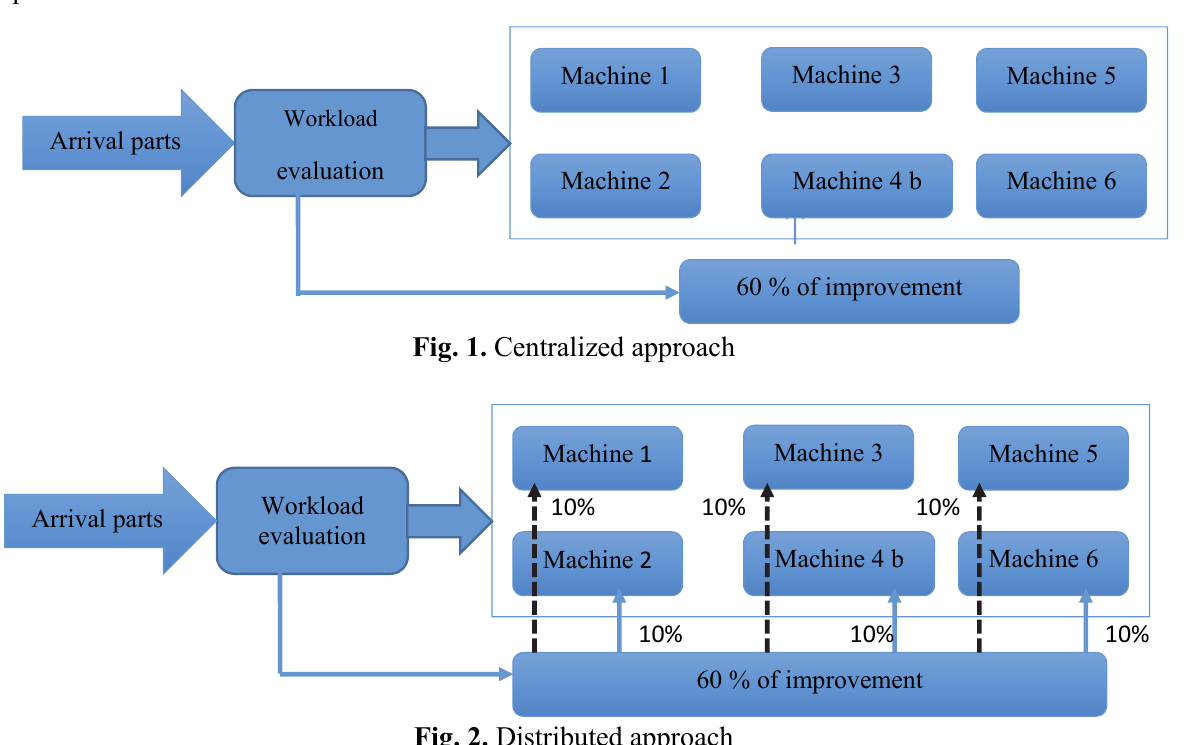
Fig. 2. Distributed